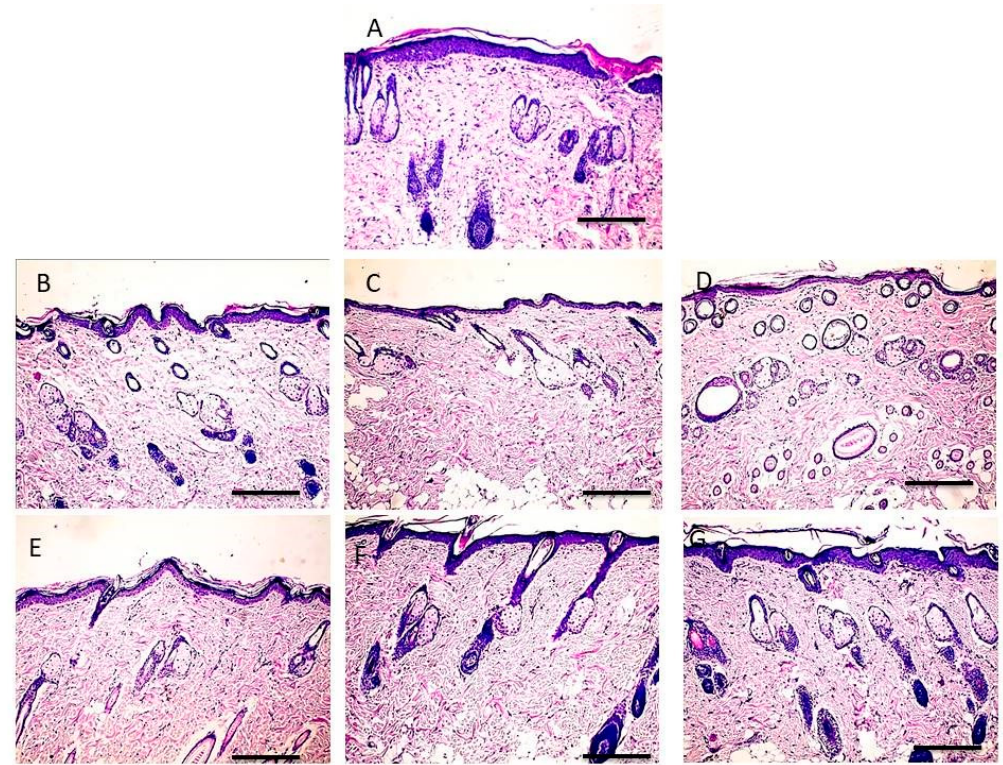
Figure 6. Microscopic pictures of H&E-stained skin sections from control rats ( A ) and rats exposed to F1 for 3 days ( B ), 7 days ( C ) and 10 days ( D ) and F4 for 3 days ( E ), 7 days ( F ) and 10 days ( G ) showing no structural damage in dermal elements (magnification 100×, bar 100).